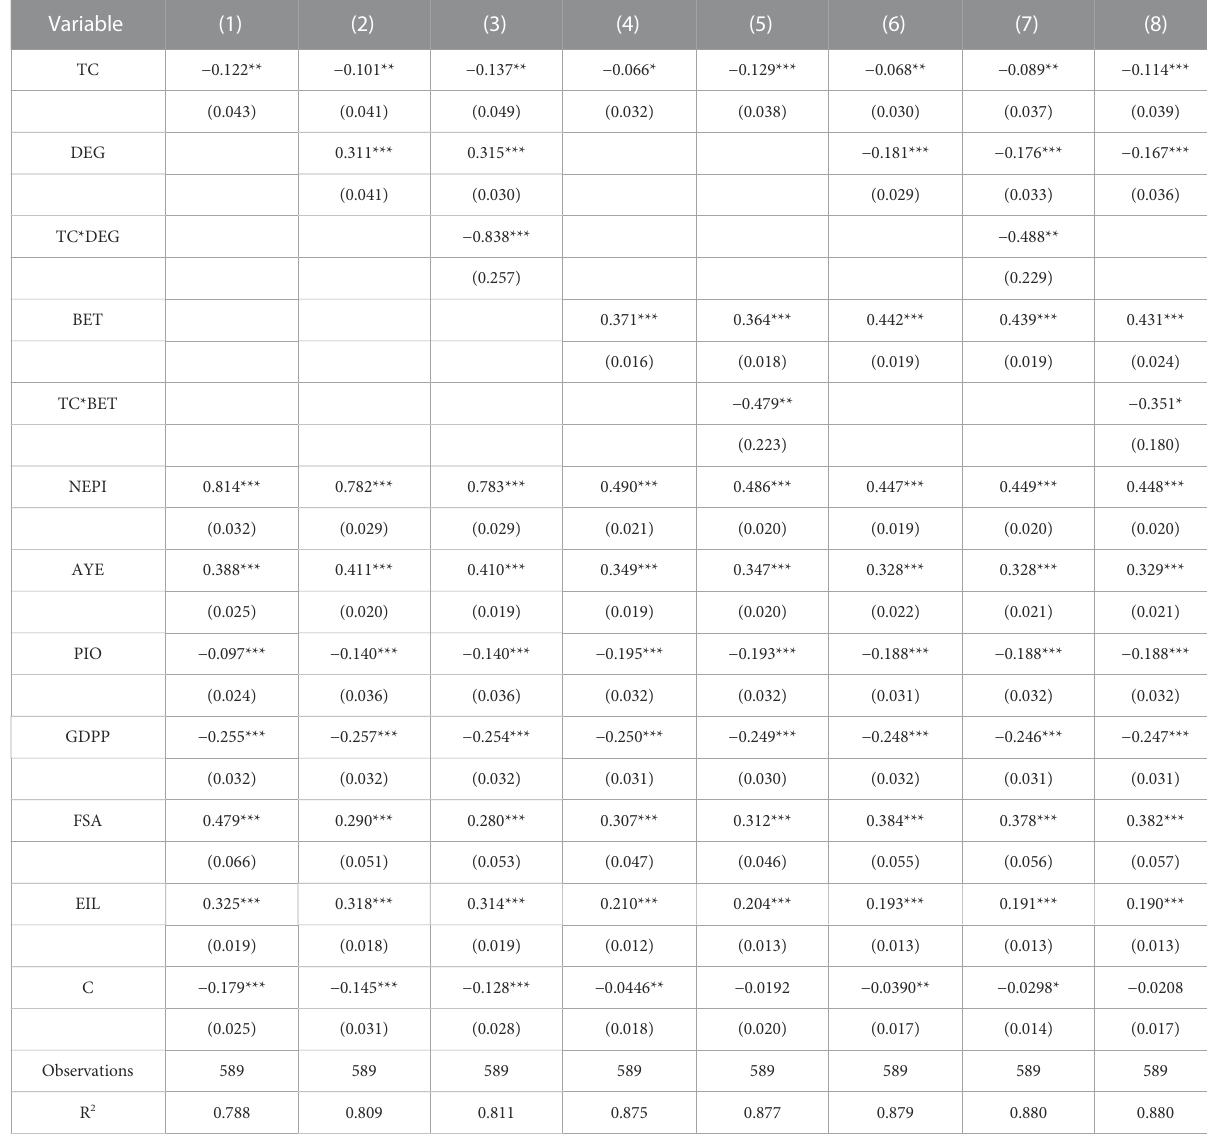
TABLE 8 Regression results of moderating effect.